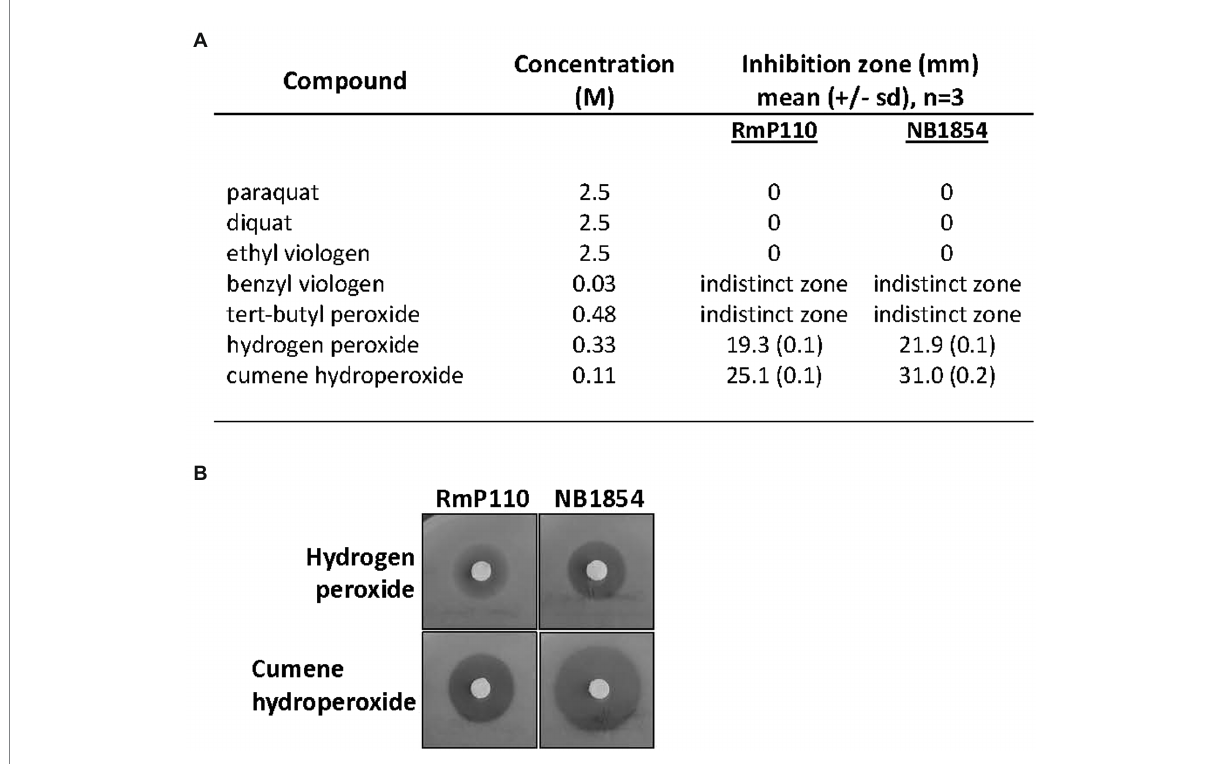
FIGURE 2 Effect of srlA deletion on resistance to oxidizing agents. (A) effects of compounds tested against wt strain RmP110 and ∆ srlA strain NB1854. Benzyl peroxide and tert-butyl peroxide resulted in inhibition zones with indistinct margins that were difficult to measure. Mean differences between host strain zone diameters were significant for both hydrogen peroxide and cumene hydroperoxide (unpaired t -test, p < 0.0001). (B) representative disc experiments testing hydrogen peroxide and cumene